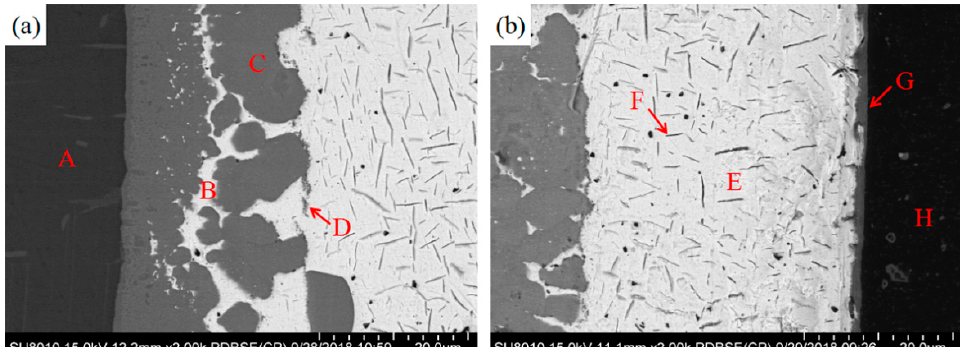
Figure 3. Scanning electron microscopy (SEM) image of the joint interface brazed at 1173 K for 15